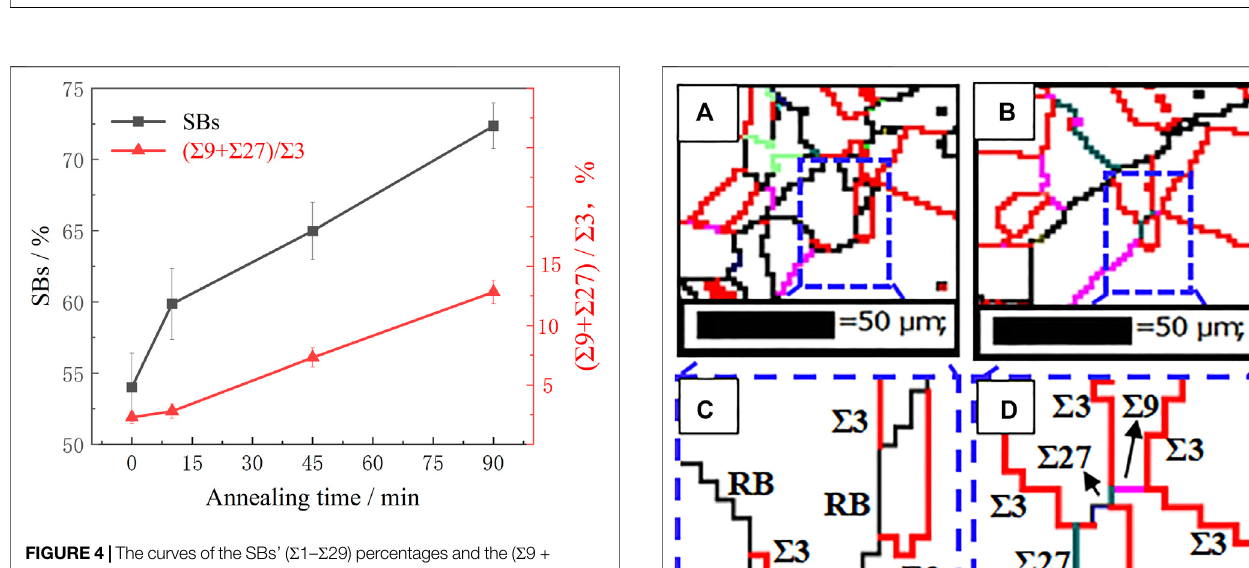
FIGURE 3 | The RHAGBs network of the (A) initial specimen and the GBE-treated specimens annealed for (B) 10 min, (C) 45 min, and (D) 90 min.